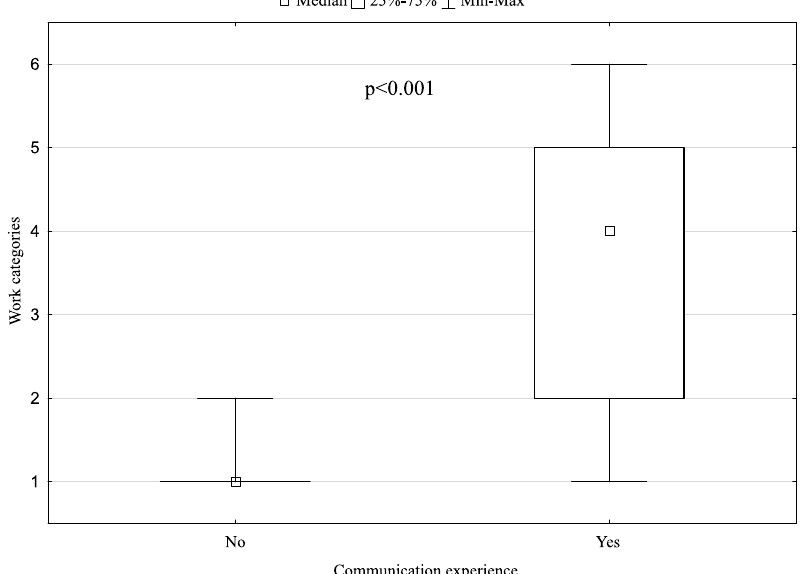
Figure 1. Length of service according to the declared experience of communi- cation with an elderly person in suicidal crisis